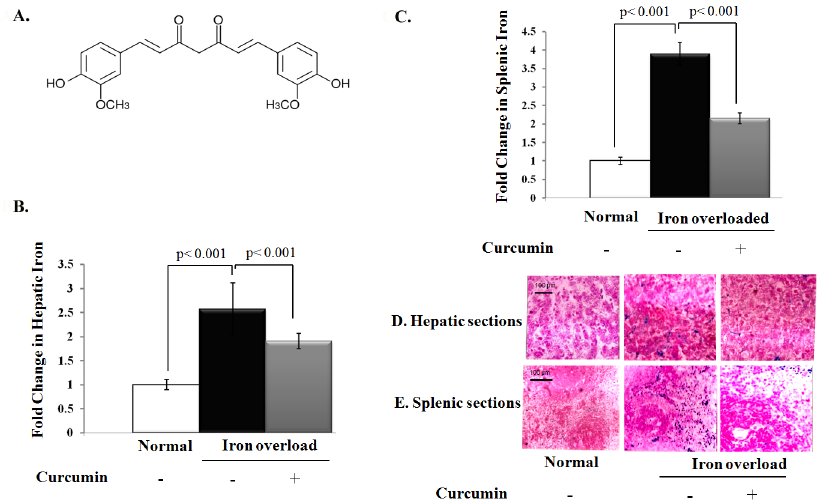
Fig 1. Potential effect of curcumin on iron accumulation within liver and spleen tissues. A) Structural characteristic of curcumin. B, C) Fold change in the level of iron ( μ mole/g tissue) in liver and spleen relative to that of normal control, which was assigned a value of 1. D, E) Histological examination of liver and spleen for iron overloaded rats with or without curcumin treatment using Prussian blue staining (blue stain).